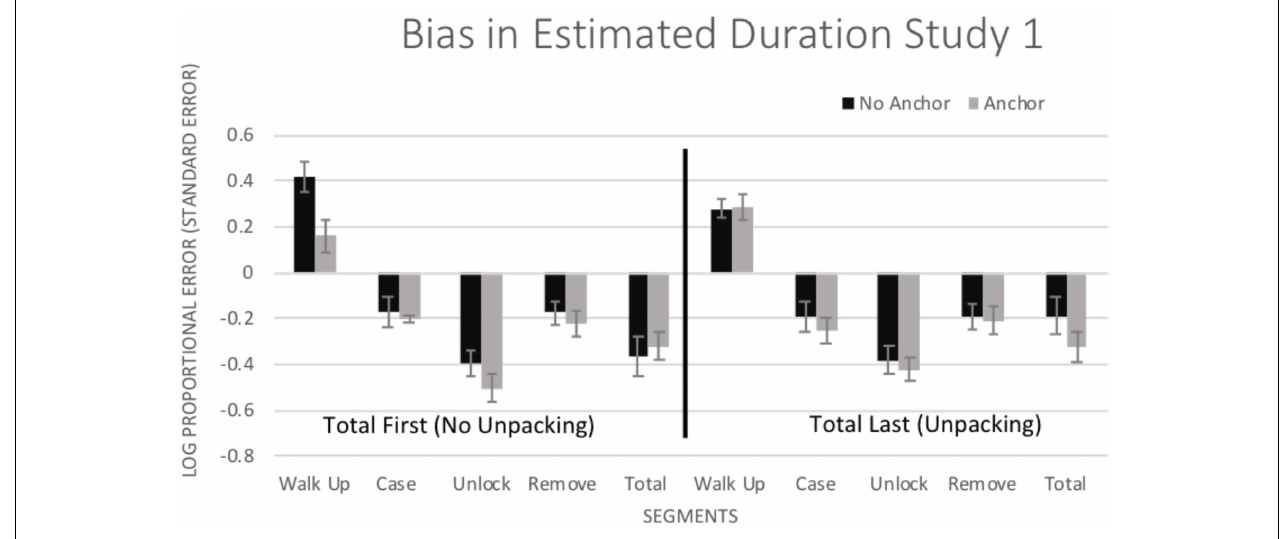
FIGURE 1 | Mean ( ± 1 SE ) bias in estimated duration (log of estimated duration/actual duration) for all of the segments of the crime. Positive values indicate overestimation and negative values indicate underestimation.